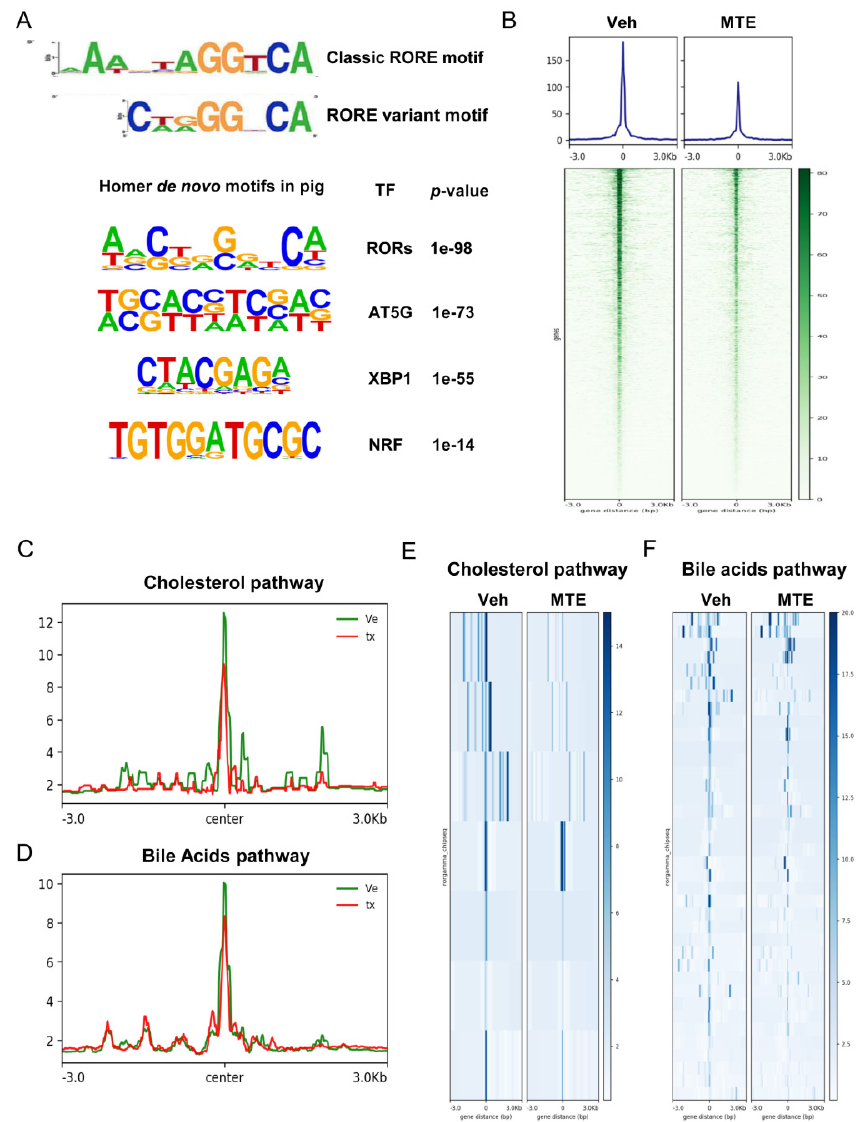
Figure 5. Mycotoxin exposure reduces ROR γ binding on cholesterol and bile acids pathways. ( A ) Homer and known transcription factor (TF) motifs analysis for ROR γ enriched peaks. ( B ) Genome − wide ChIP − Seq profiles and heat − map of ROR γ signal intensity within +/ − 3 kb regions around the peak center. ( C , D ) ChIP − Seq profiles of ROR γ binding on genes enrolled in cholesterol − bile acids metabolism pathway. ( E , F ) Heat-map of ChIP − Seq signal intensity as ( C , D ).